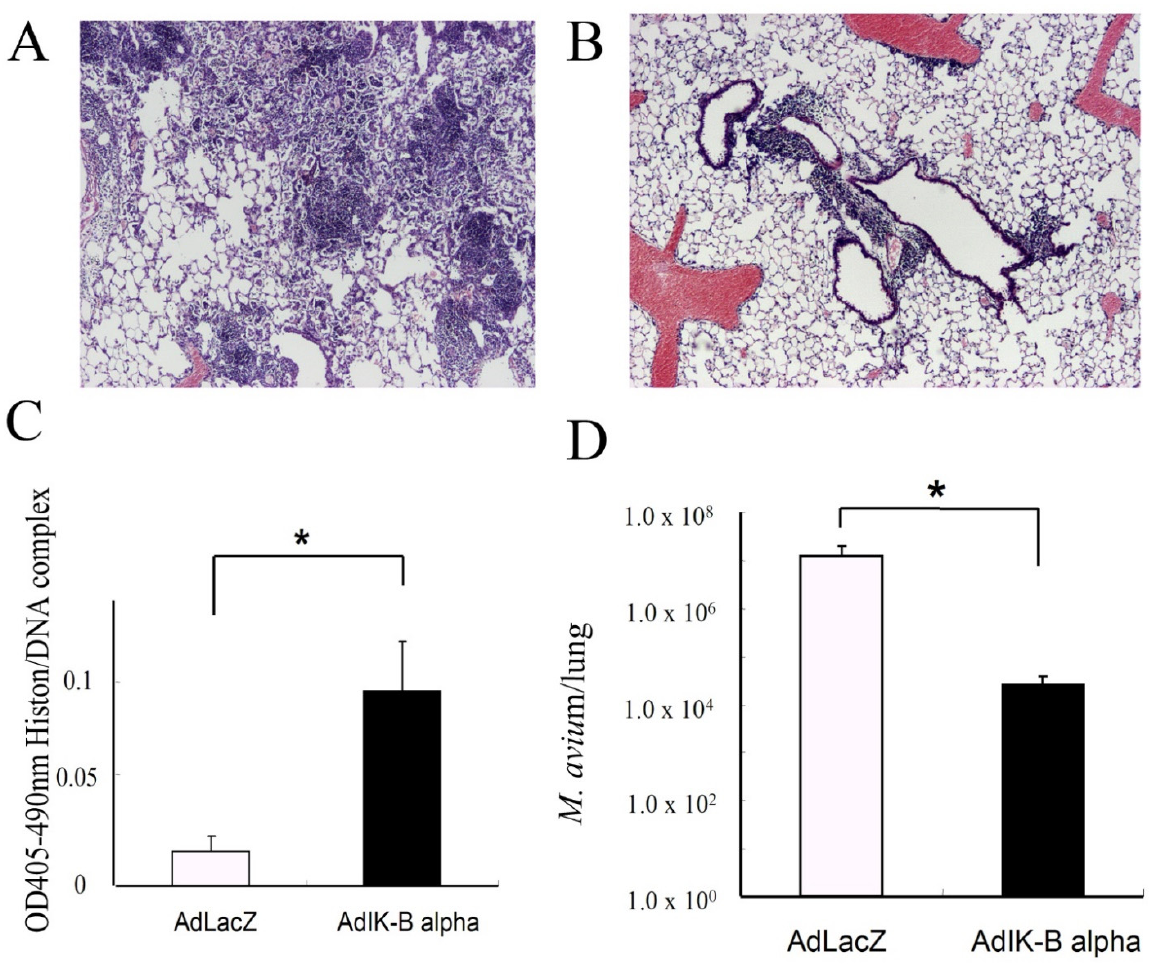
Figure 7. Histology of lungs from mice 60 days after M. avium administration. ( A ) Perforin-KO mice administered M. avium followed by instillation of AdLacZ. ( B ) Perforin-KO mice administered M. avium followed by instillation of AdI κ -B. The reduced inflammatory cell infiltrate in the lungs from Perforin-KO mice with AdI κ -B alpha was noted. H-E staining, original magnification × 40. Three experiments were done and demonstrated similar results. ( C ) The effect of apoptosis-related gene deficiency on histone/DNA complexes in BAL fluids at day 21 after M. avium infection. AdLacZ: mice administered AdLacZ as a control, AdI κ -B alpha: mice administered AdI κ -B alpha. High titers of histone/DNA complexes were observed in mice administered AdI κ -B alpha. Data are shown as the mean (SEM) obtained from five mice (* p < 0.01). ( D ) Bacterial growth of M. avium in the lungs of mice at day 21 after M. avium inoculation. Each group consisted of five mice. * Indicates significant differences ( p < 0.05). AdLacZ: mice administered AdLacZ as a control, AdI κ -B alpha: mice administered AdI κ -B alpha.